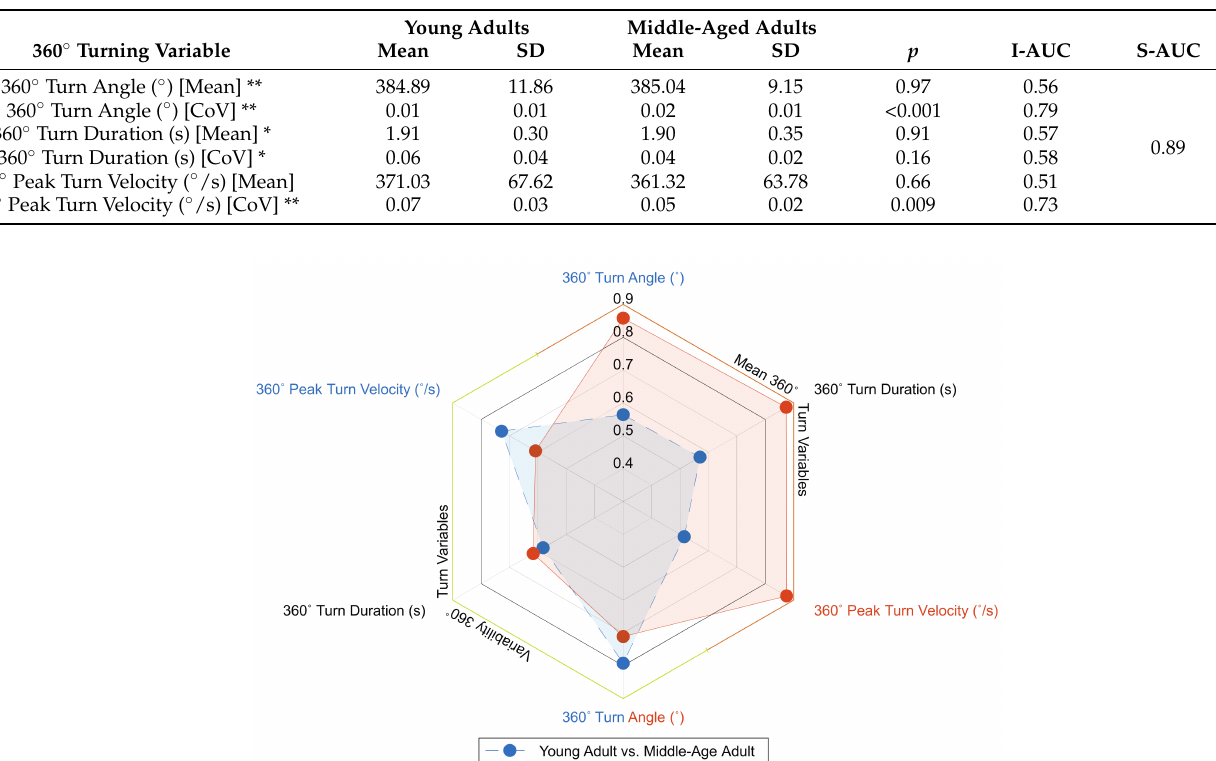
Table 4. Means, standard deviations, significance ( p ), independent AUC (I-AUC), and stepwise AUC (S-AUC) measures for 360 ◦ turning variables. Variable(s) with a single (*) were included in the stepwise regression, those with a (**) were maintained in the regression model for further AUC assessment and discriminatory ability.